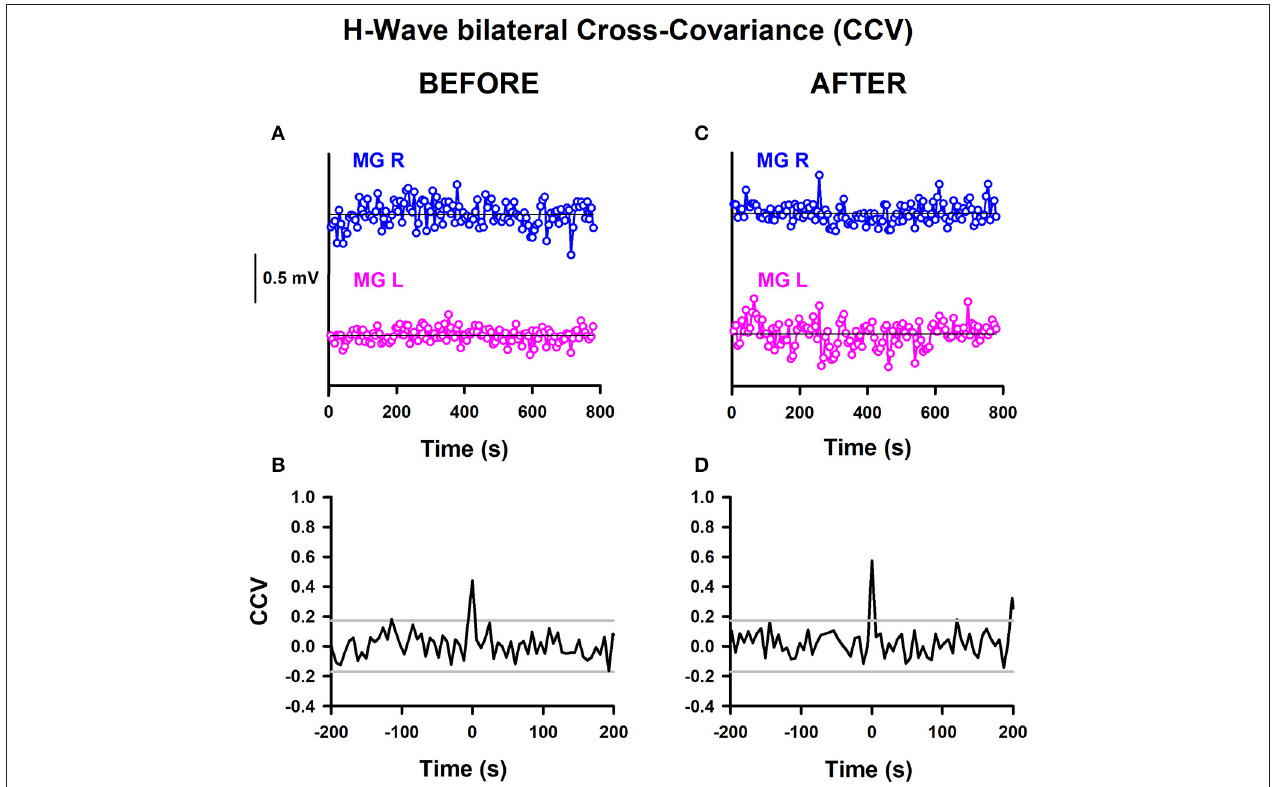
FIGURE 5 | H-wave bilateral cross-variance before and after training. (A) Sequence of H-wave amplitude fluctuations for the MGR and MGL: (A) before training and (C) after training. CCV of H-wave amplitude fluctuations: (B) before training and (D) after training. The data obtained from both legs were detrended by subtraction of the best straight line fit to the time